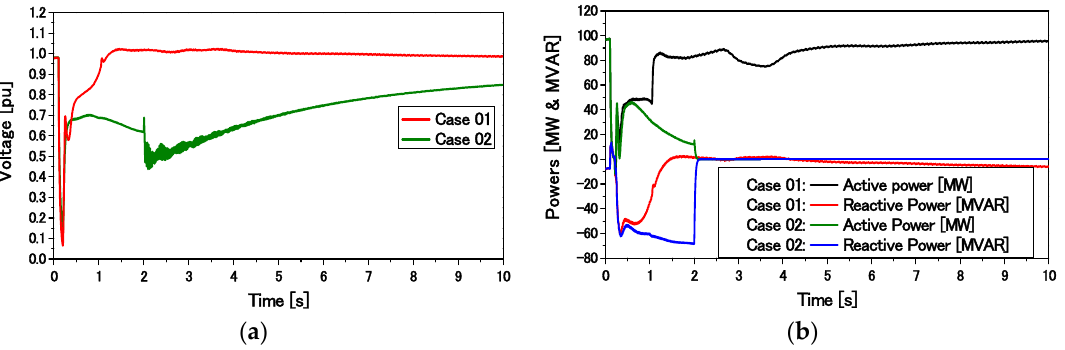
Figure 18. Individual response of the WF at bus 12: ( a ) Voltage at connection point; ( b ) total active and reactive power at connection point.